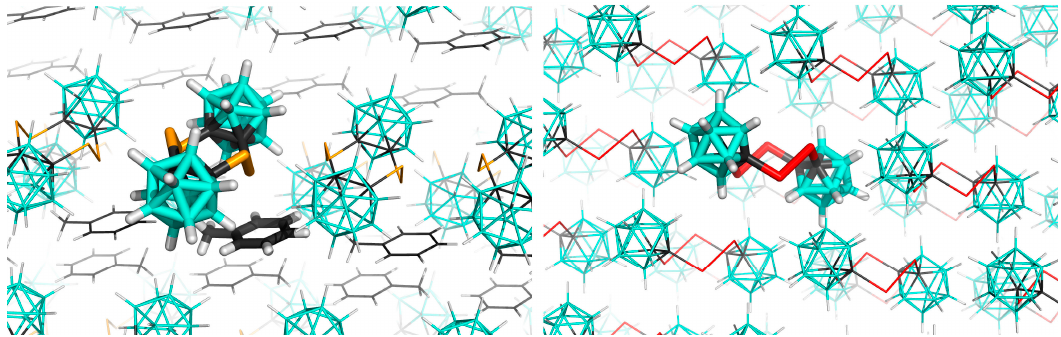
Figure 3. The crystal packing in the crystal of Se 4 C 4 •toluene (left) and the single crystal of Te 4 C 4 (right). The atom color coding is as follows: cyan—B; black—C; orange—Se; white—H; red—Te. Table 2. Computed DFT-D3/TPSS/TZVPP interaction energy ( Δ E) values for the most stable motifs in the crystal of Se 4 C 4 •toluene. Interaction energies were decomposed into electrostatic (E elec ), induction (E ind ), dispersion (E disp ), and exchange (E exch ) contributions using the SAPT0/jun-cc-pVDZ